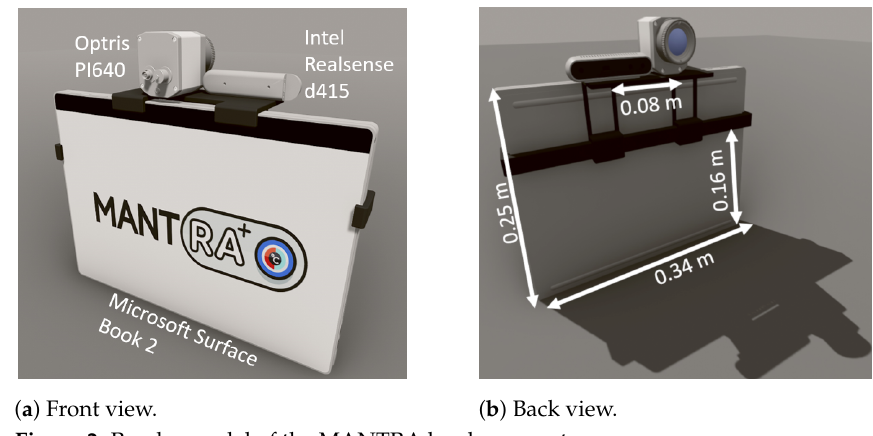
Figure 2. Render model of the MANTRA hardware